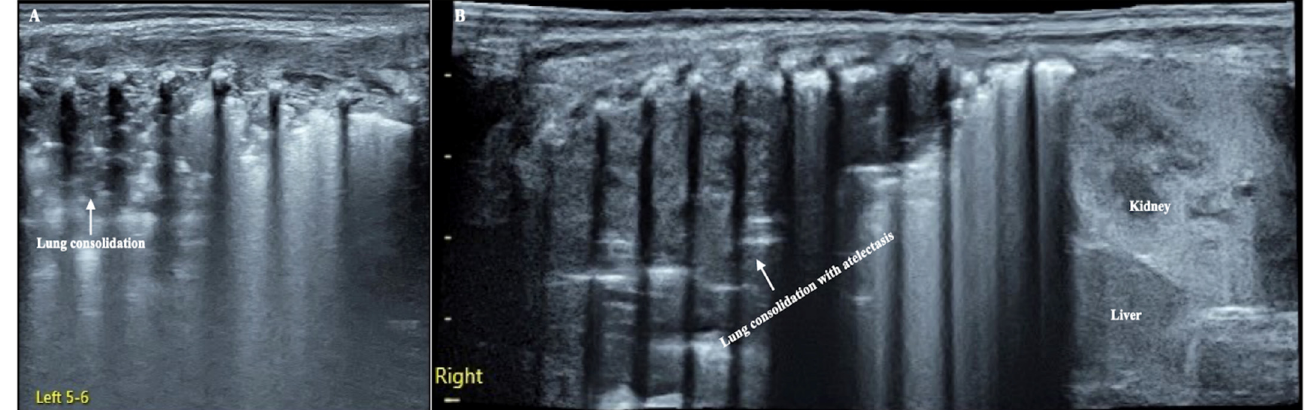
Figure 1. LUS manifestation of the patient. ( A ): Left lung. Large-area lung consolidation with jagged boundaries (mainly involved the upper lung field), while in the lower lung field, lung edema and subpleural consolidation were predominant, which indicate the presence of pneumonia [1]. ( B ): Right lung (extended view). Lung consolidation was almost involved in the whole lung field with regular edges, and there was almost no bronchial aeration in the consolidation area, which means that the entire right lung was atelectatic [2].